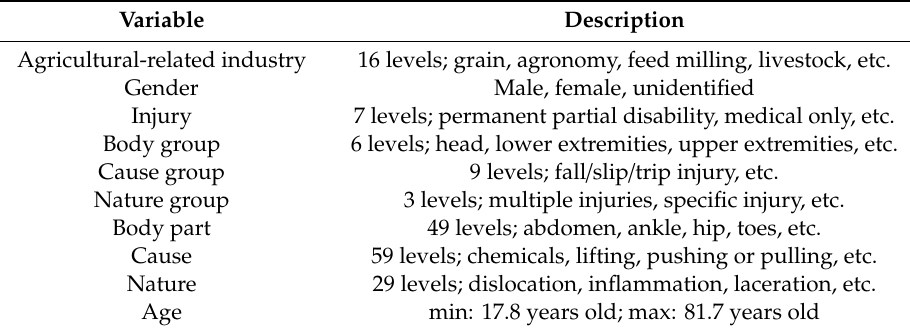
Table 2. Description of variables used in the